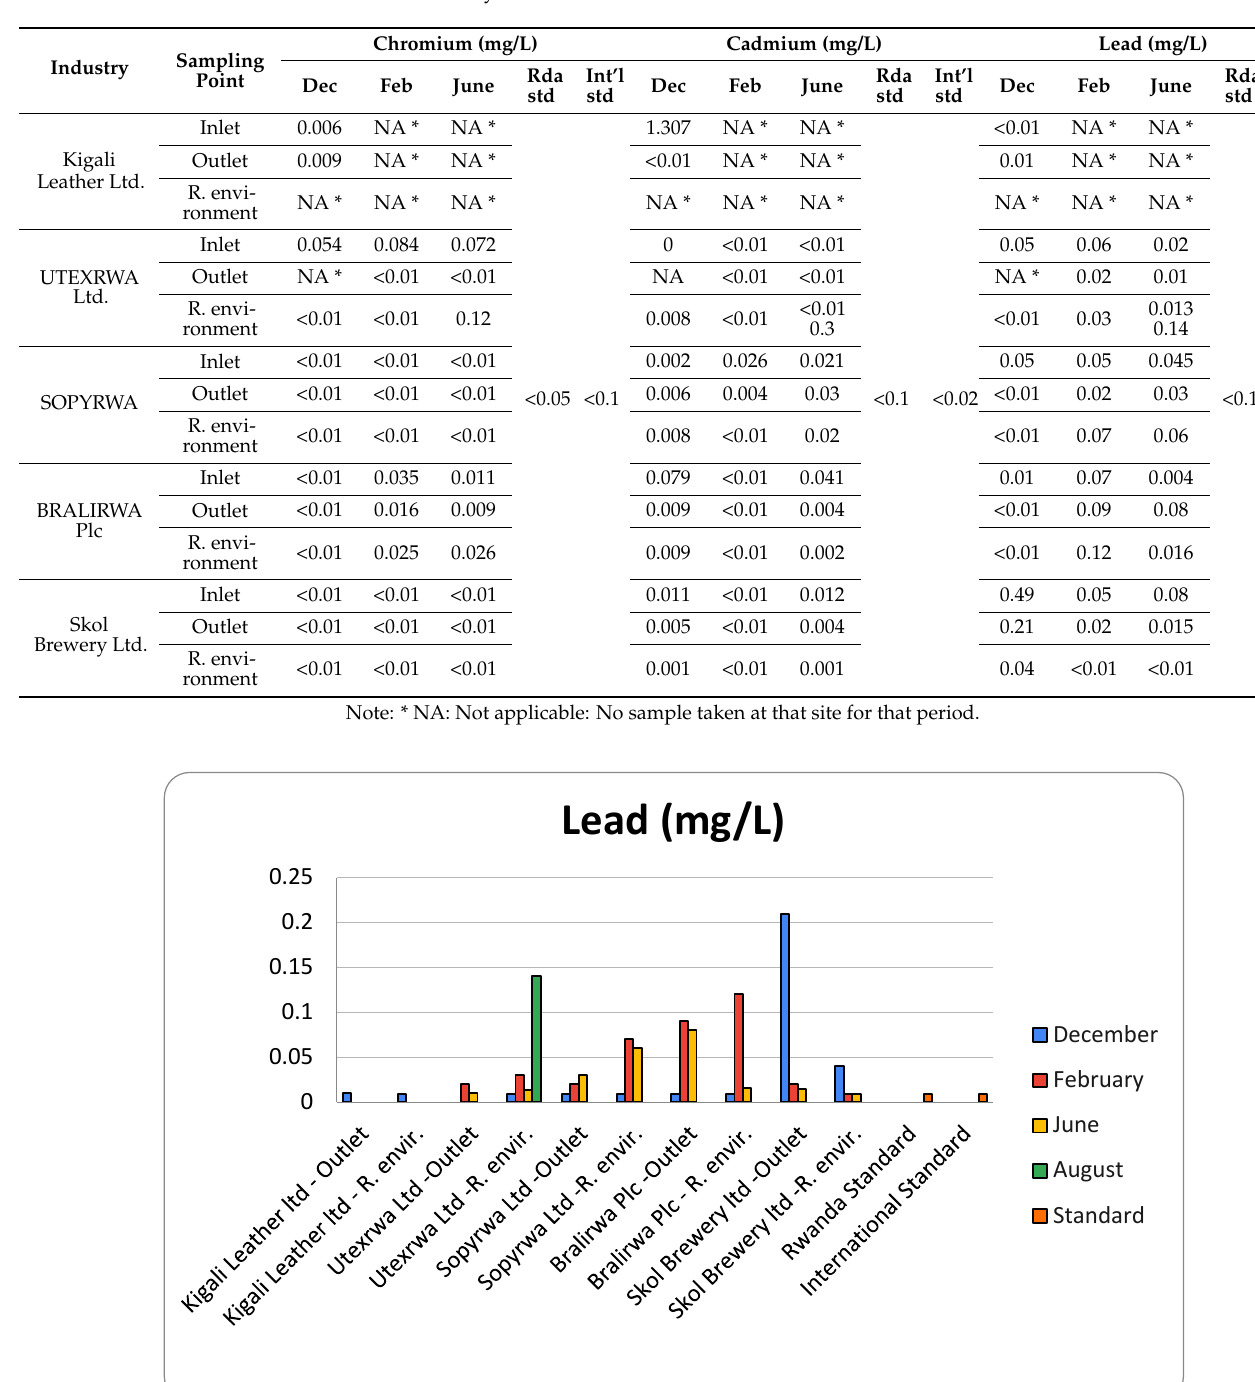
Table 7. Heavy metal results for the selected industries.